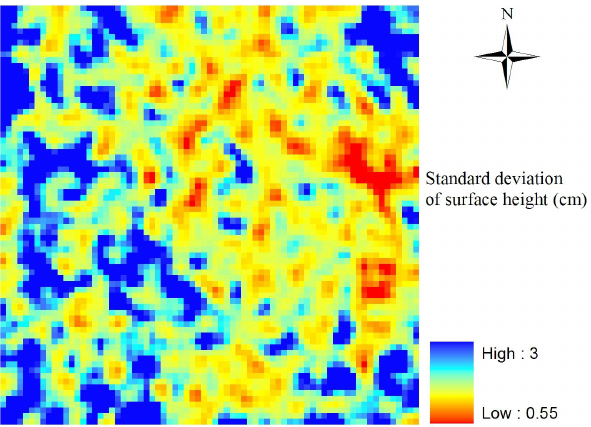
Figure 5. Estimated results of the standard deviation of surface height from multi-angular ASAR images.